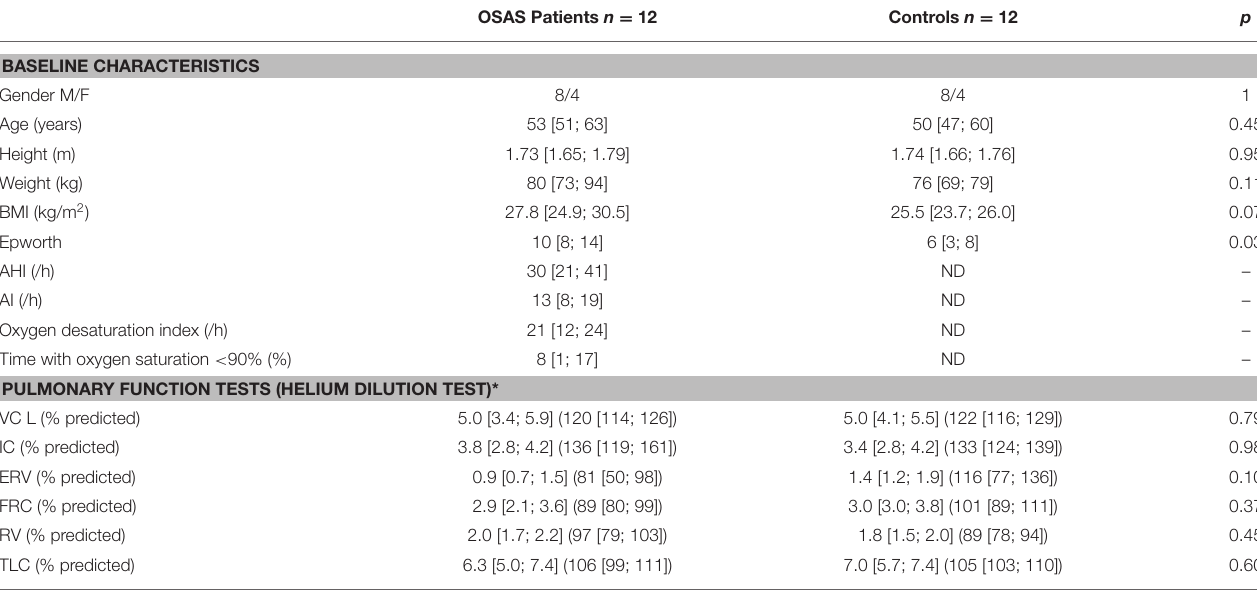
TABLE 1 | Baseline characteristics and pulmonary function tests.